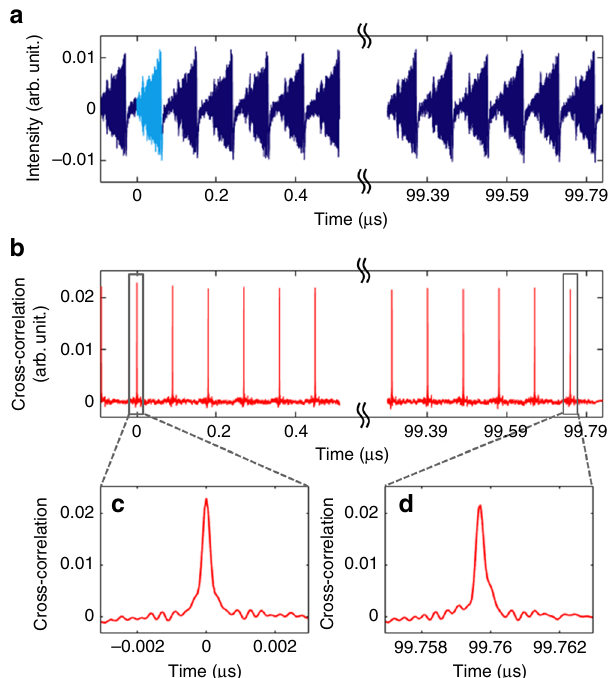
Fig. 9 Mutual coherence of RFCWs. a Sequence of ~1110 consecutive measured RFCWs used for numerical calculation of the temporal cross- correlation trace. The reference waveform is plotted in light blue. b Cross- correlation trace. The auto-correlation trace (correlation of the reference with itself) corresponds to null delay time. c , d Comparison of the auto- correlation peak ( c ), with the cross-correlation signal obtained for a delay of ~100 µ s, i.e., between the reference waveform (#1), and the waveform